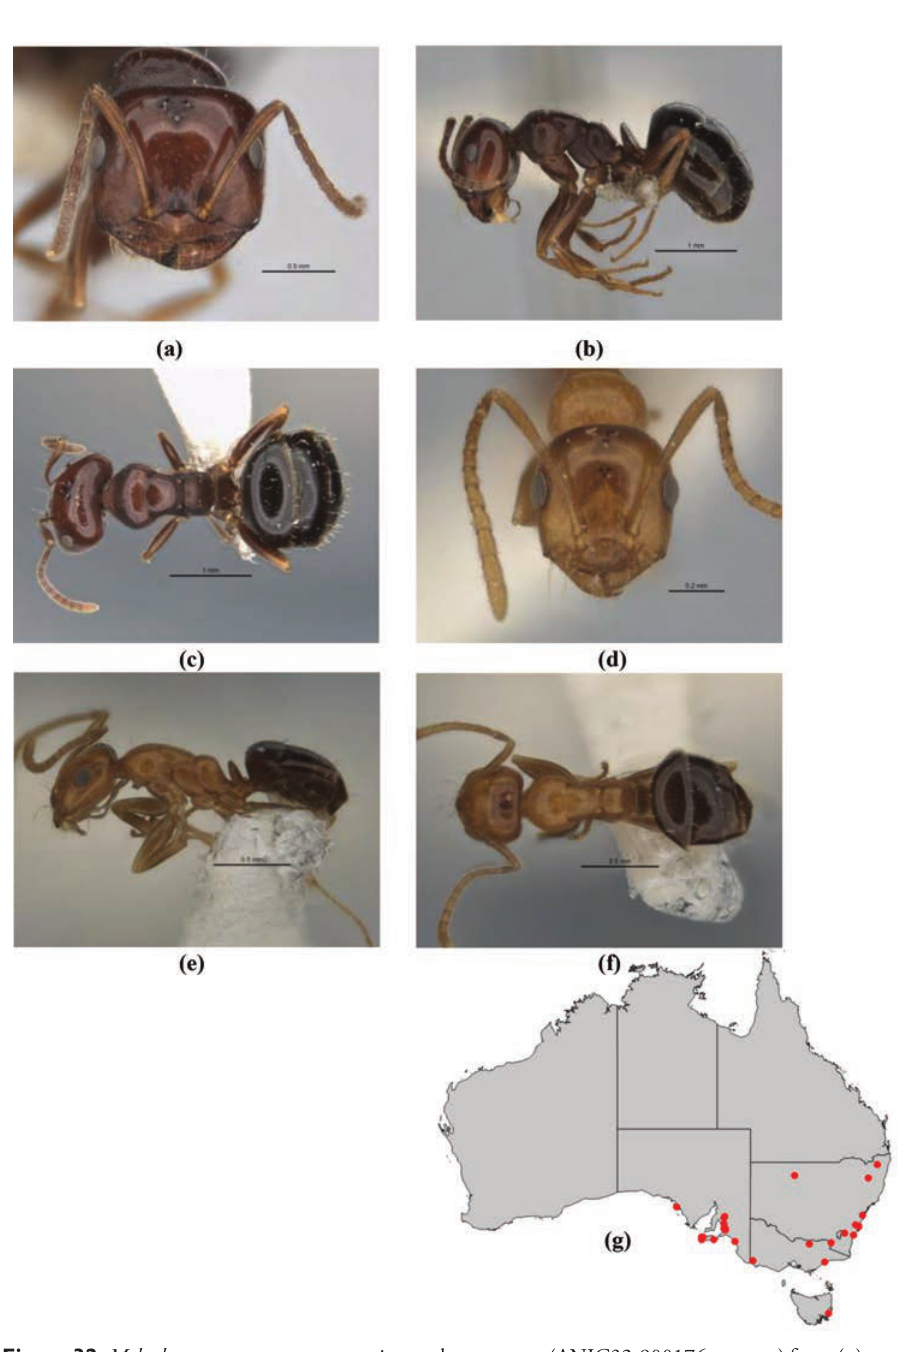
Figure 32. Melophorus castanopus sp. n.: major worker paratype (ANIC32-900176–top ant) frons ( a ), pro- file ( b ) and dorsum ( c ); minor worker holotype (ANIC32-900113–middle ant) frons ( d ), profile ( e ) and dorsum ( f ); distribution map for the species ( g ). Low resolution scale bars: 1 mm ( b, c ); 0.5 mm ( a, e, f ); 0.2 mm ( d